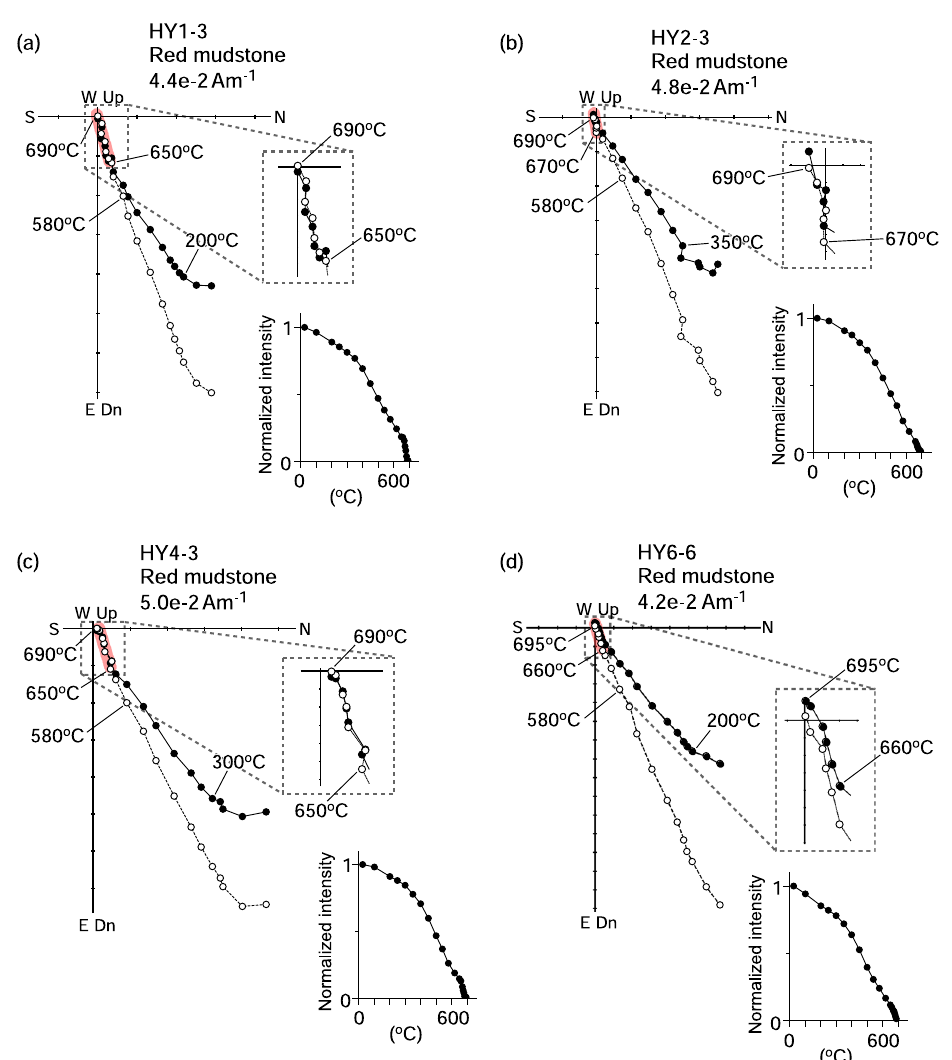
Fig. 3 Representative orthogonal plots and normalized remanence intensity curves of thermal demagnetization results of red mudstones in geographic coordinates. Solid and open symbols on orthogonal plots represent projections on the horizontal and vertical planes, respectively. The highlighted magnetization component denotes the high-temperature remanent magnetization